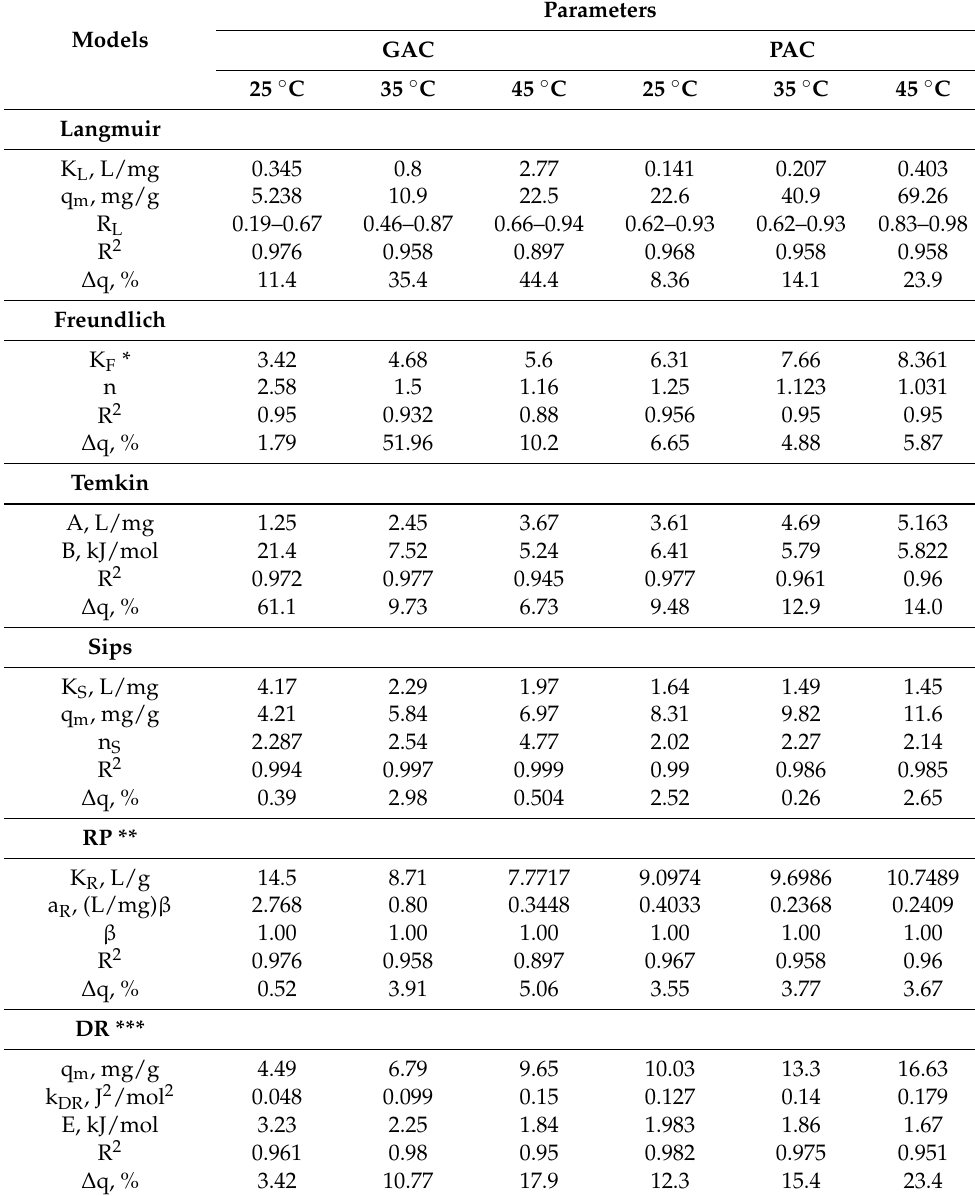
Table 2. Adjustment of the isotherm models in the adsorption of DNS in AC.